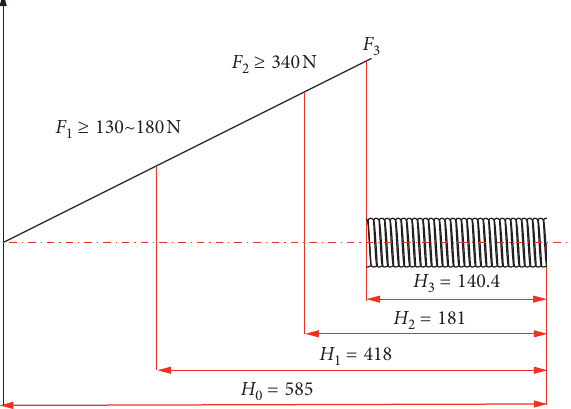
Figure 6: The characteristic curve of recoil